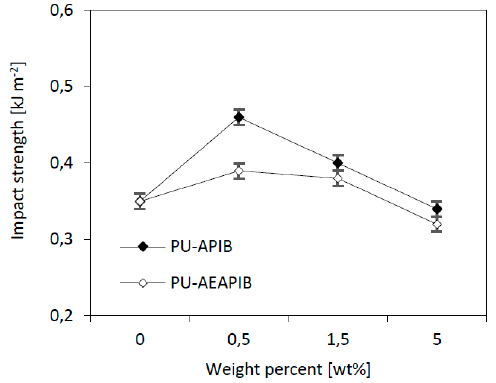
Figure 9. Effect of POSS’s content on impact strength of RPUFs.